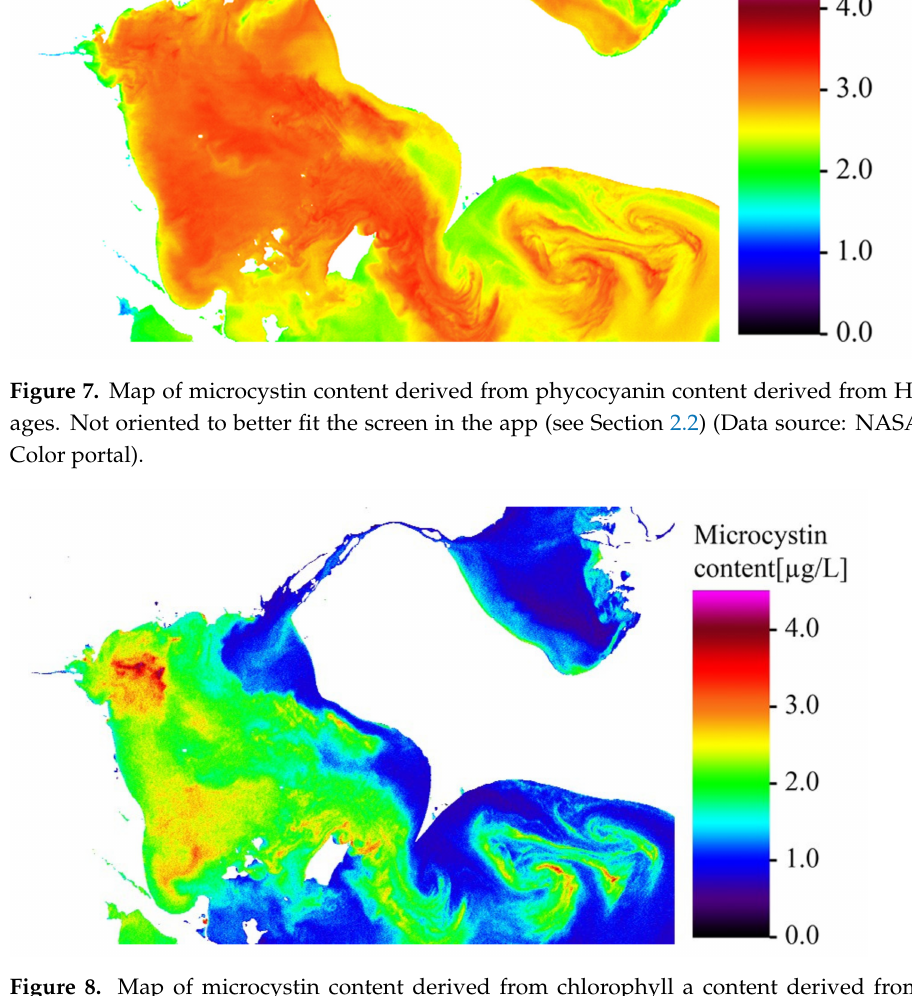
Figure 8. Map of microcystin content derived from chlorophyll a content derived from HICO images. Not oriented to better fit the screen in the app (see Section 2.2) (Data source: NASA Ocean Color